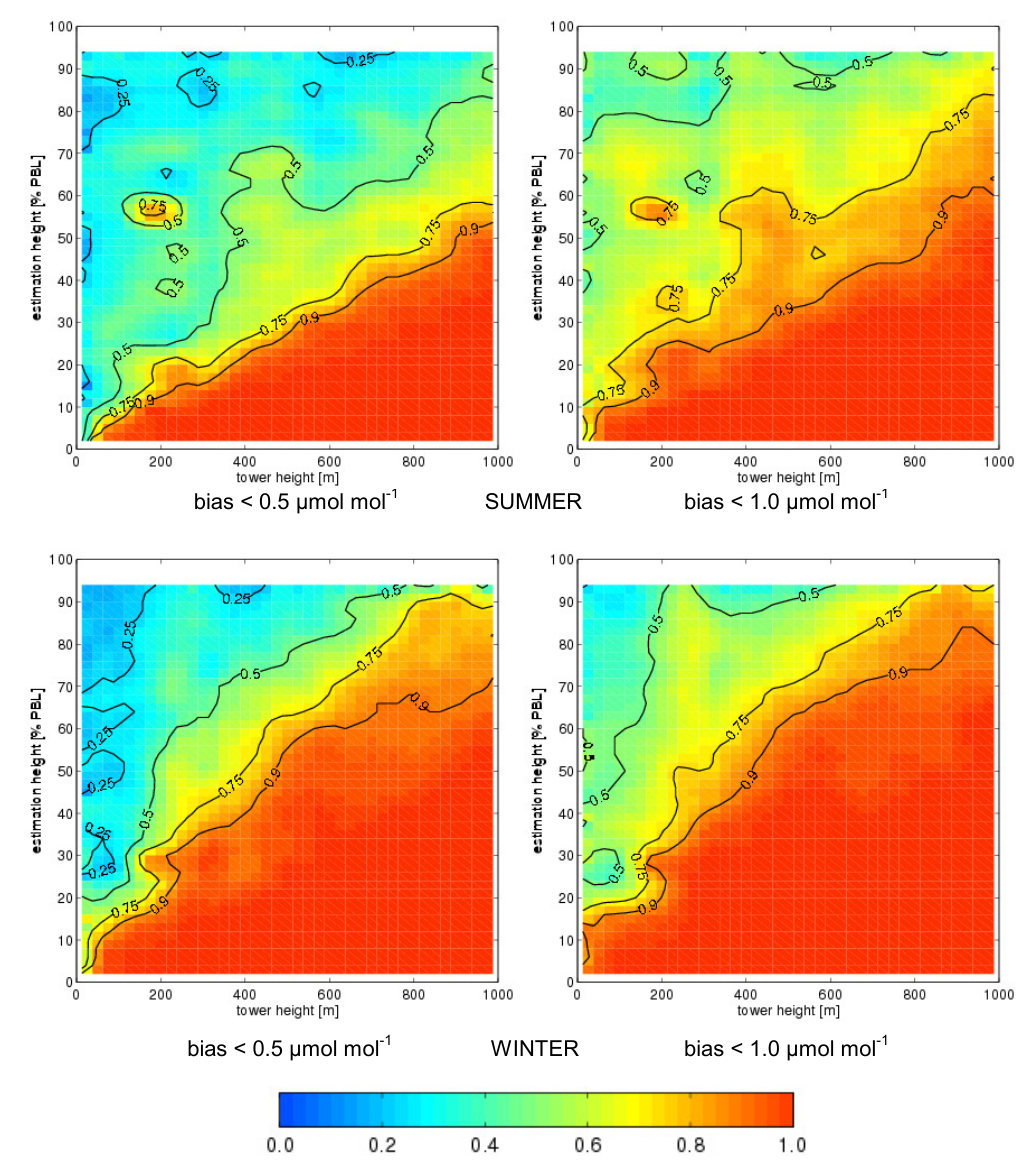
Figure 6. Empirical probability of the cases when the bias between the true CO 2 mole fraction and the estimated one does not exceed 0.5 (left) or 1.0µmolmol − 1 (right) at the application of the VTT concept as the function of the height of the hypothetical tower and the estimation height relative to the height of the PBL in summer (top) and winter